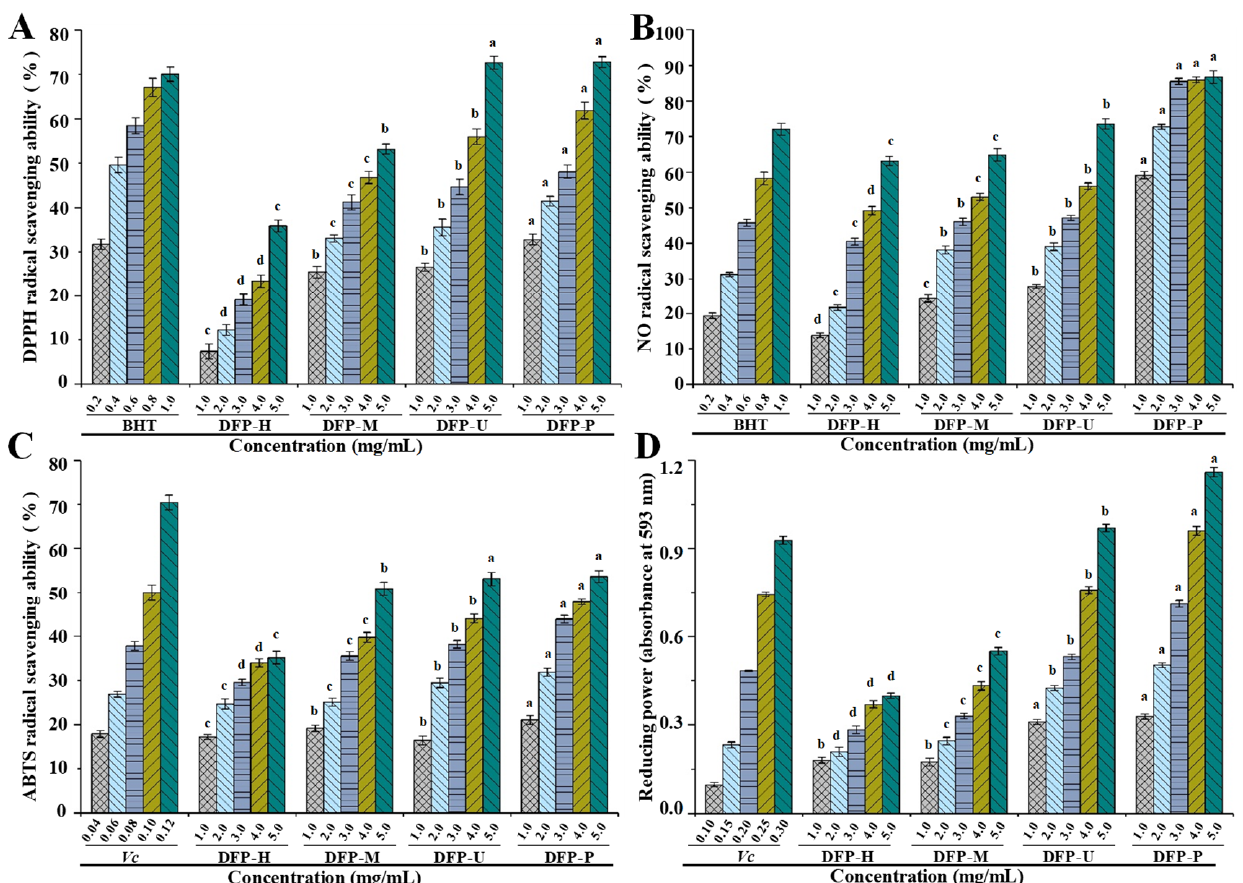
Figure 3. DPPH ( A ); NO ( B ) and ABTS ( C ) radical scavenging activities and reducing powers ( D ) of DFP-H, DFP-M, DFP-U, and DFP-P ( D. indusiata polysaccharides prepared by HWE, MAE, UAE, and PAE, respectively); The error bars are standard deviations; Significant ( p < 0.05) differences among in vitro antioxidant activities of D. indusiata polysaccharides prepared by different extraction methods at the same concentration are shown by data bearing different letters (a–d), respectively; Statistical significances were carried out by ANOVA plus post hoc Duncan’s test.